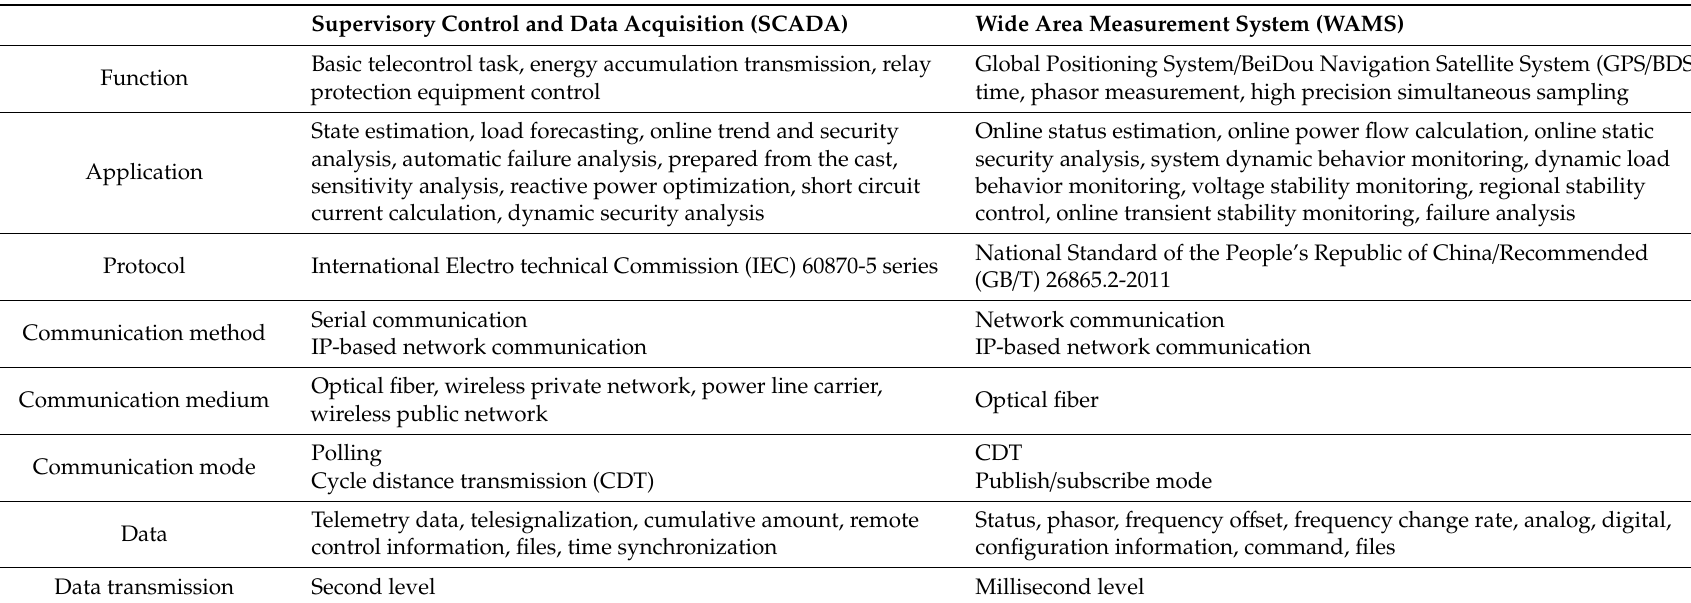
Table 2. System function